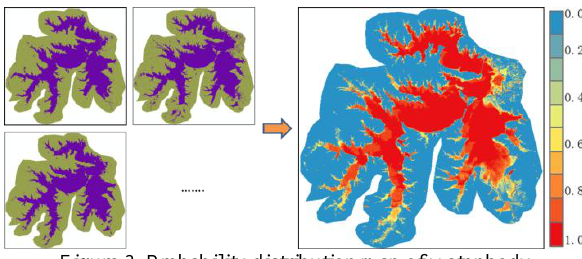
Figure 3. Probability distribution map of water body